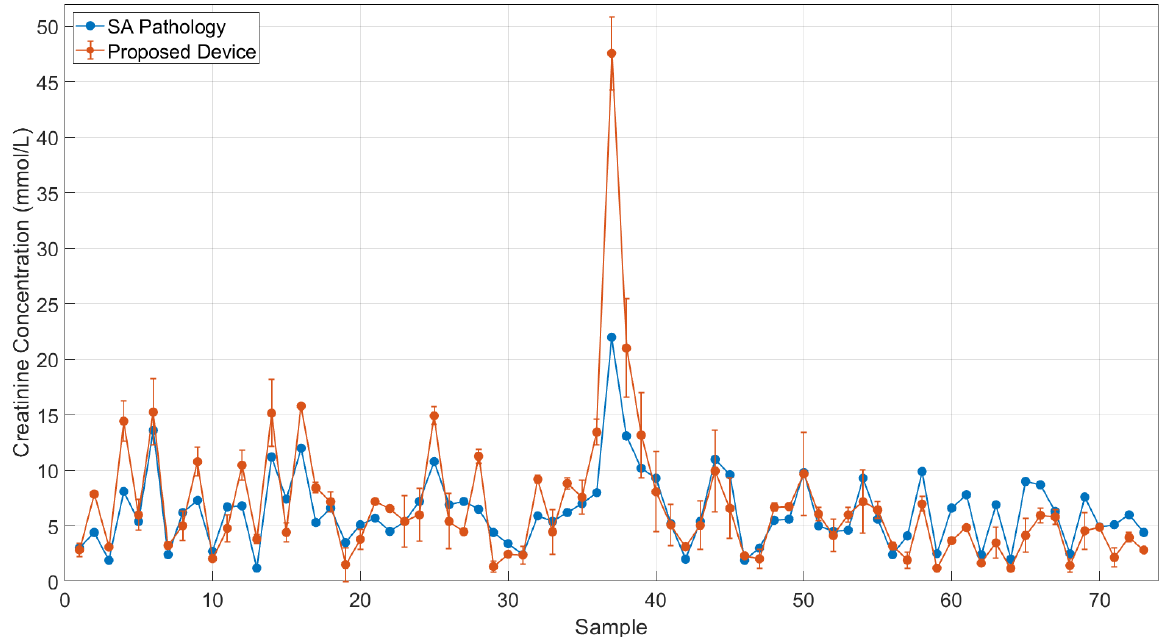
Figure 5. Comparison of creatinine concentrations measured by device and obtained from SA Pathology for 73 urine samples. The biggest variation is in sample 37, which has a strong intensity in the background colour. Standard deviation is for two replicate samples.